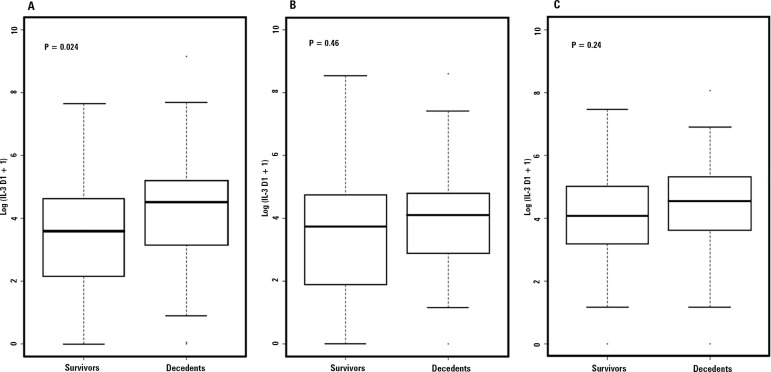
Circulating levels of IL-3 on days 1, 3 and 7 according to
in-hospital survival. Box plots with median levels of interleukin-3
(IL-3), interquartile ranges and 10th and 90th
percentiles on days 1 (A), 3 (B), and 7 (C). Levels of IL-3
expressed in logarithmic form.